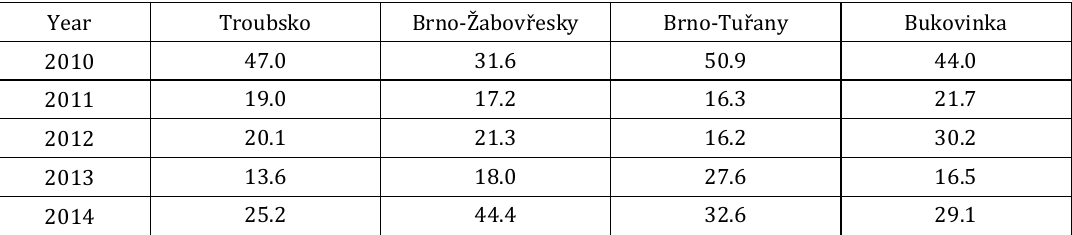
Table 2. Maximum torrential rain totals in Brno (2010 – 2014)